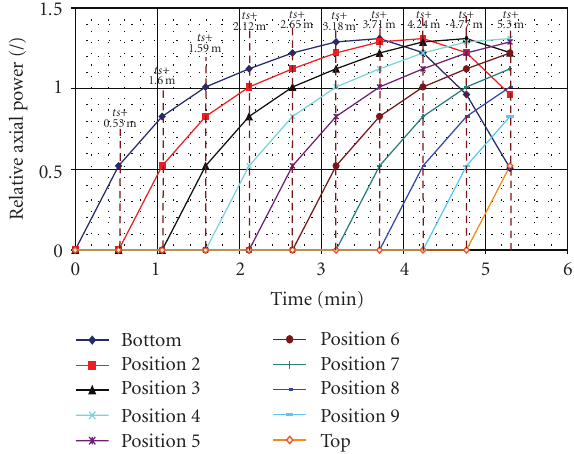
Figure 6: Relative axial power history during refueling as a function of time for di ff erent axial position, fuel rod